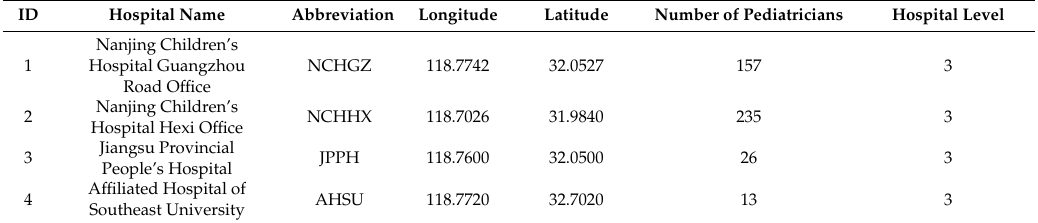
Table A1. Hospitals in Nanjing o ff ering pediatric